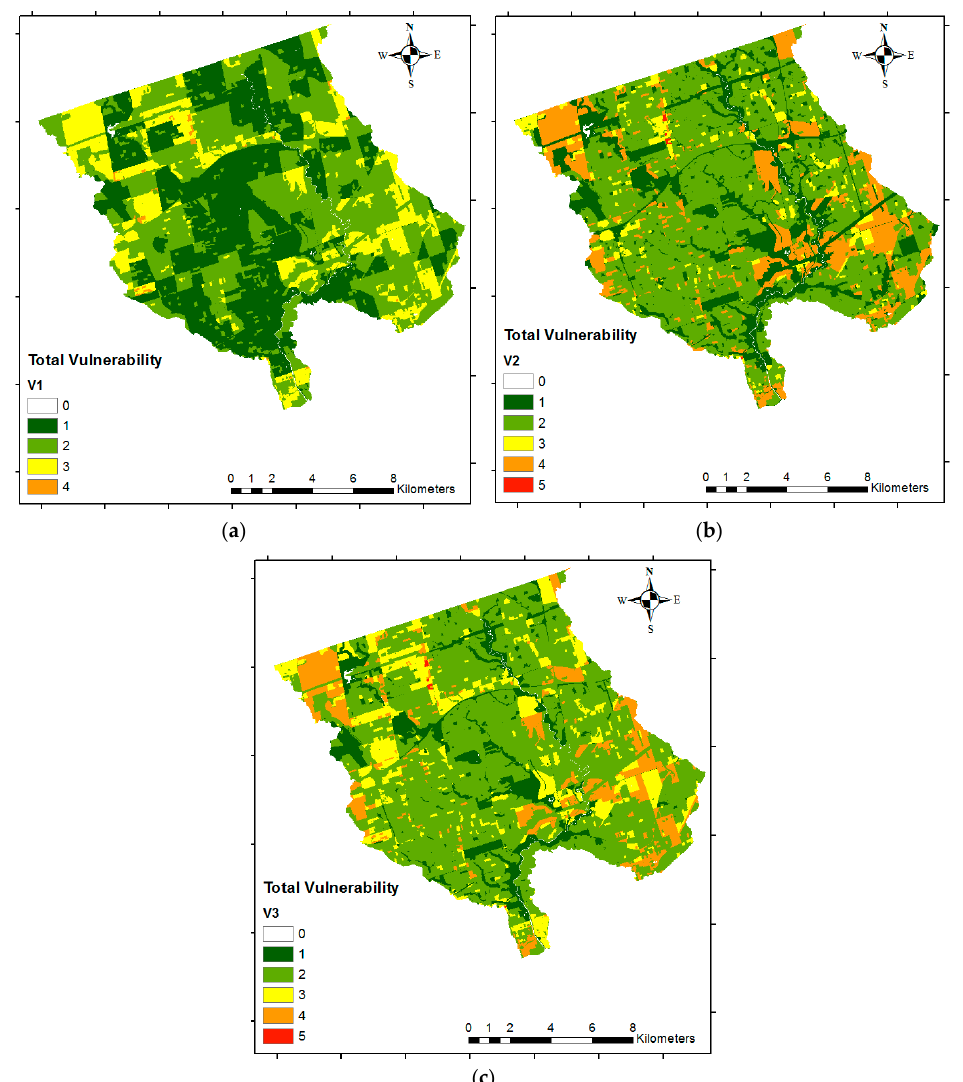
Figure 7. Vulnerability maps; ( a ) social vulnerability; ( b ) economic vulnerability.